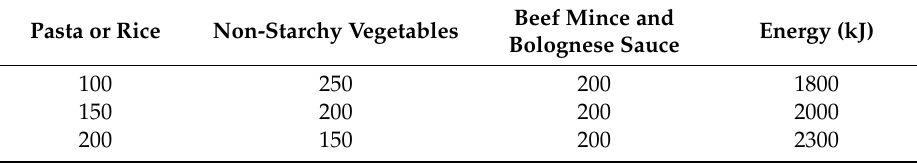
Table 1. Cooked weights (g) and energy content of the test